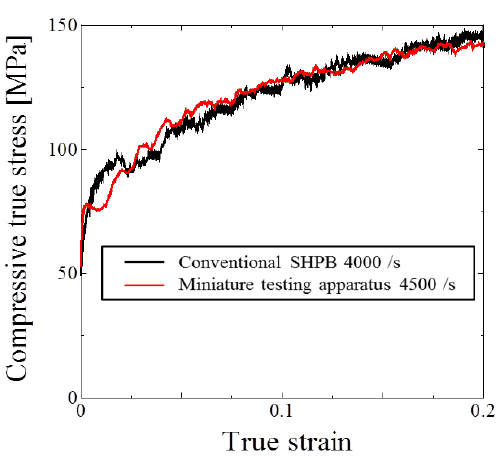
Figure 5. A comparison between the stress-strain curves obtained by the conventional and miniature testing apparatuses.